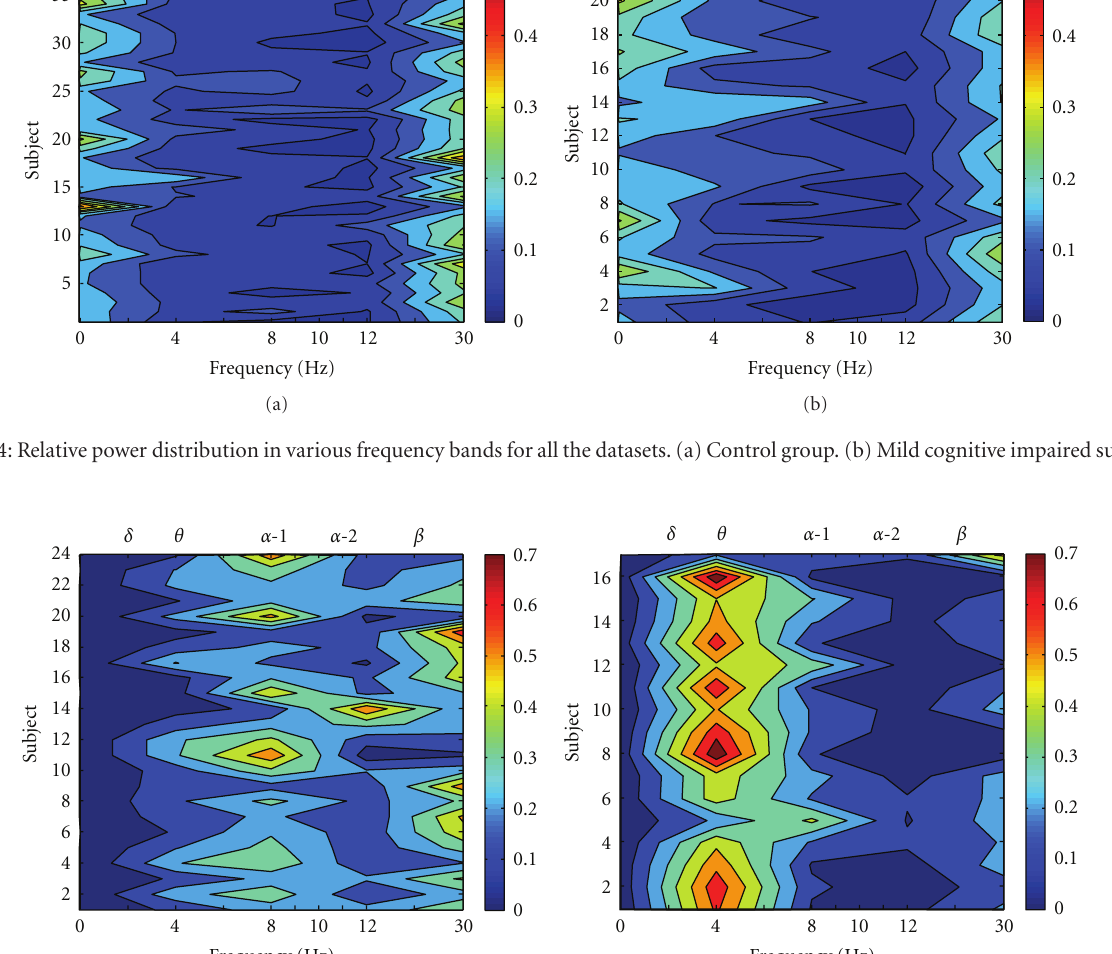
The lifting wavelet transform provides a sparse,